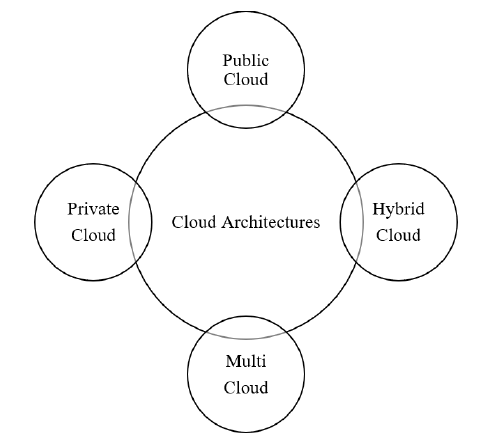
Figure 4. Types of cloud